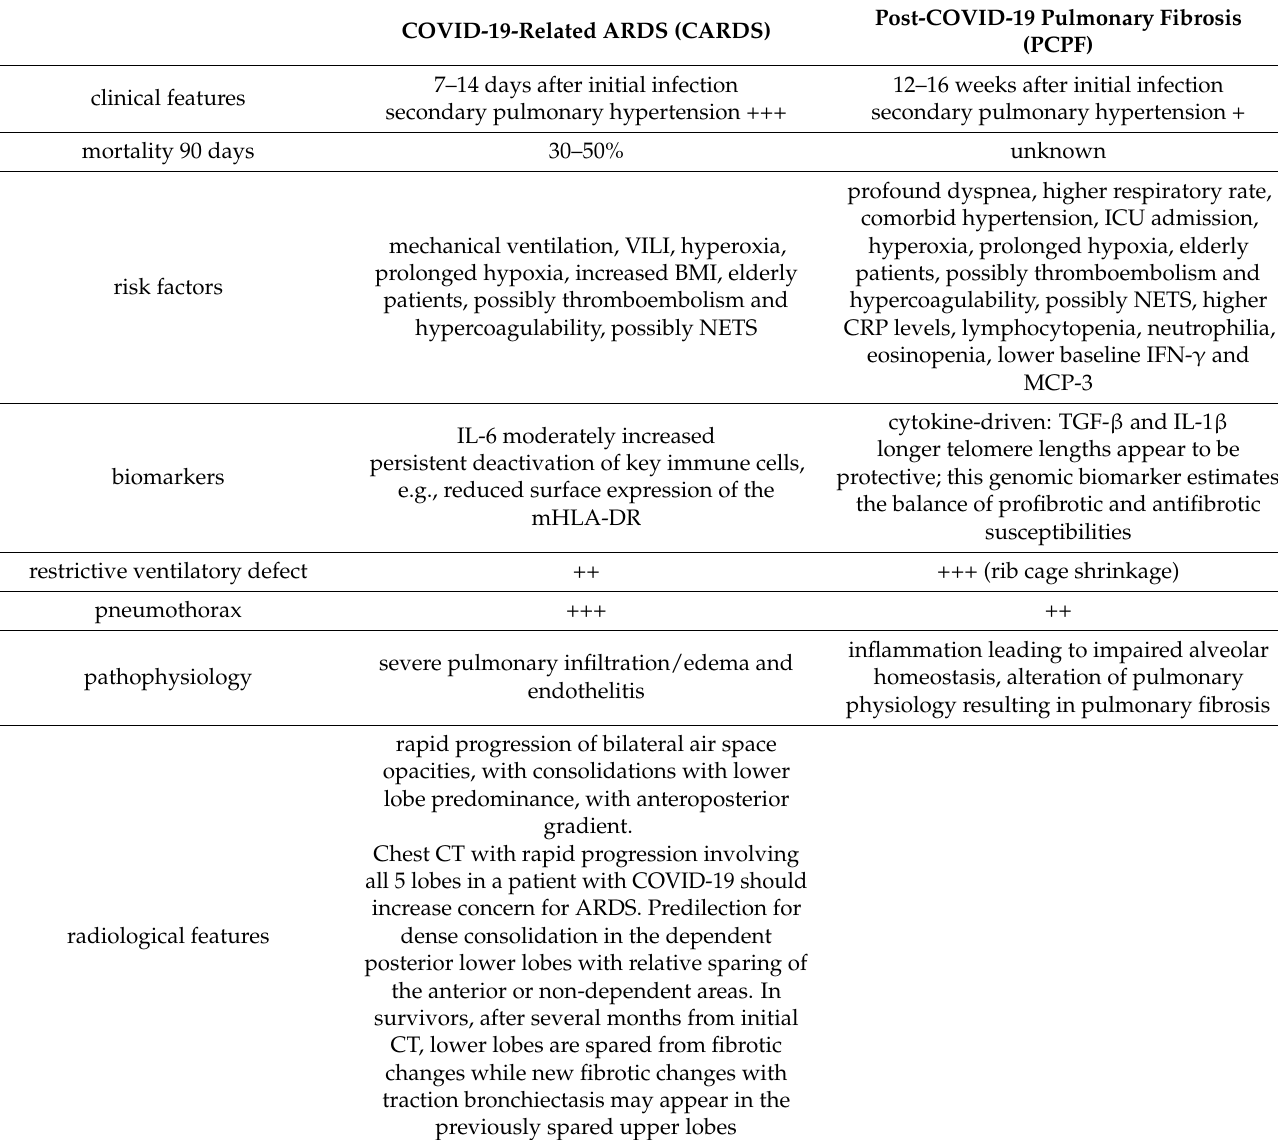
Table 1. Different aspects of the two phenotypes of COVID-19-associated lung